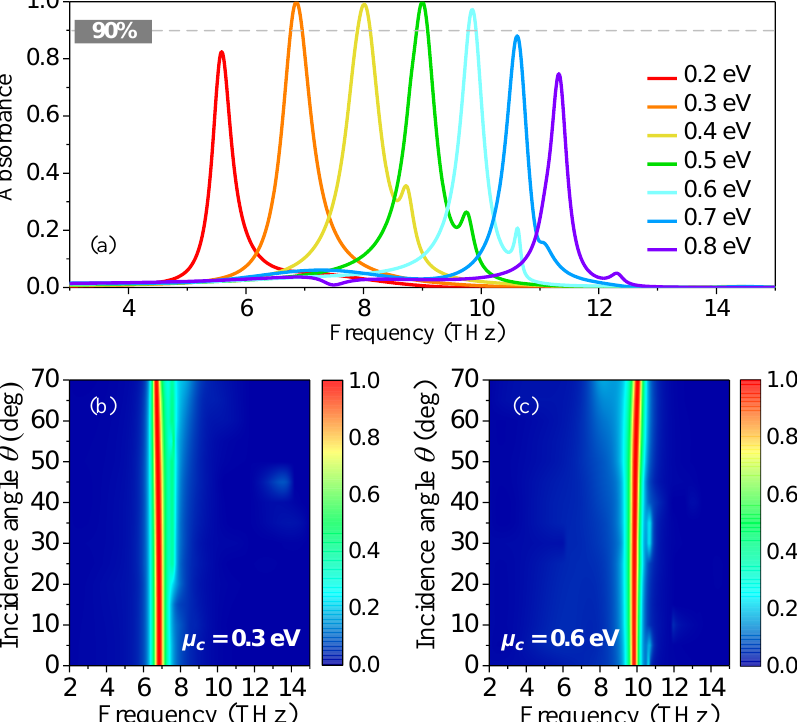
Figure 4. ( a ) Simulated absorption spectra for both TM and TE polarizations under normal incidence with μ c ranging from 0.2 to 0.8 eV; ( b ) and ( c ) are the absorbance spectra as a function of incidence angle and operating frequency with μ c fixed as 0.3 and 0.6 eV, respectively.